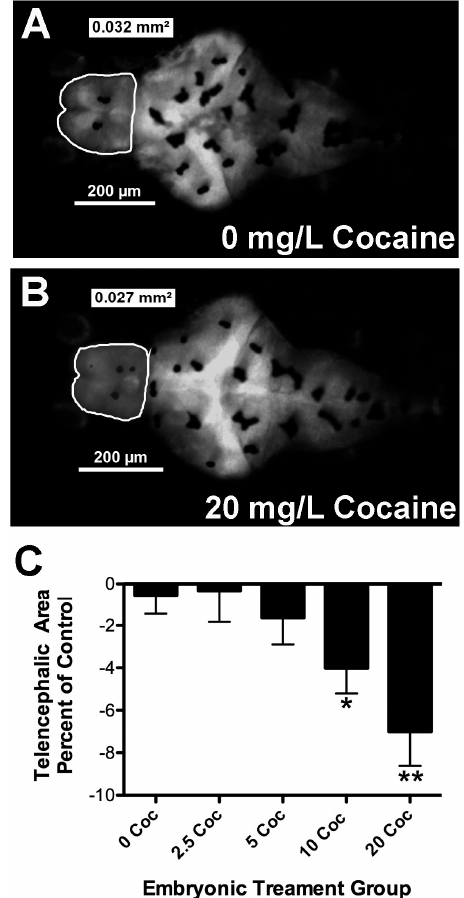
Figure 2. Cocaine treatment decreases telencephalic area of zebrafish larvae. There was a readily observed decrease in telencephalic size seen after treatment with the highest doses of cocaine. Panels A and B provide a comparison between untreated fish ( A ) and siblings treated with 20 mg/L cocaine ( B ); In ( C ), results from several experiments were combined, with brain size expressed as a percentage of untreated controls. Brain size was reduced on average 7% by treatment with 20 mg/L cocaine. Error bars signify ± SEM, * p < 0.05 relative to control and ** p < 0.01 relative to untreated control.